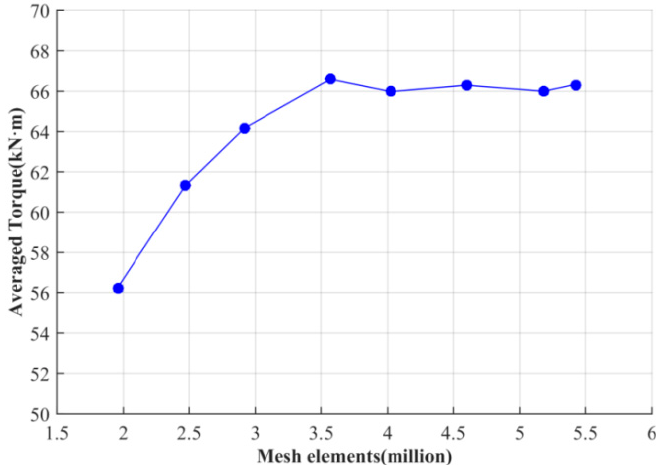
Figure 1. Geometric model and grids of the wheel domain.